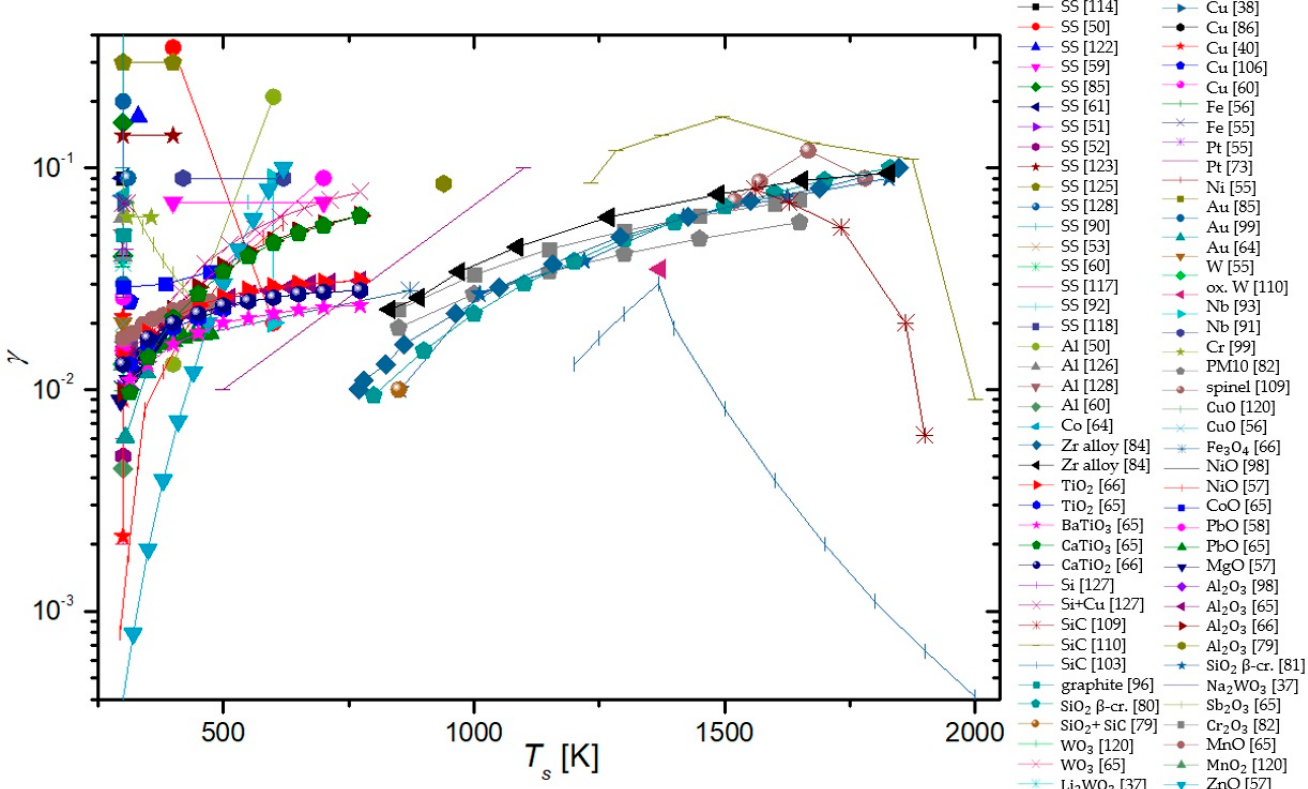
Figure 19. Recombination coefficient ( γ ) of neutral oxygen atoms versus surface temperature ( T s ) for various semi-catalytic surfaces.